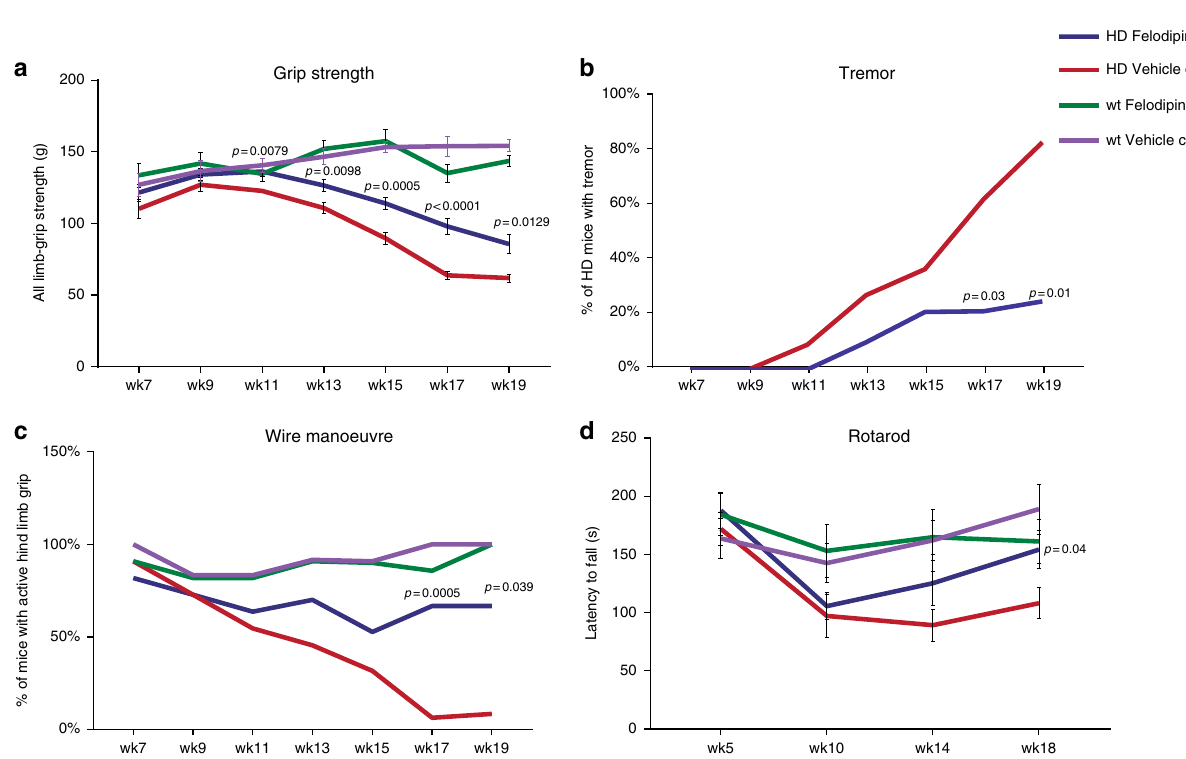
Fig. 3 Ef fi cacy study of felodipine in N171-82Q (B6HD) mice. B6HD male mice were given i.p. injections of 5 mg/kg felodipine or carrier substance (vehicle control) three times a week from 6 weeks of age. Wild-type mice littermates were also given felodipine or vehicle control injections with the same frequency. n = 22 mice for B6HD mice for both felodipine and vehicle control groups, while n = 11 for wild-type felodipine-treated littermates and n = 12 for wild-type vehicle-treated littermates. a Felodipine improved grip strength in B6HD mice. All B6HD mice showed some age dependent decline in grip strength compared to wild-type littermates regardless of treatment. However, felodipine signi fi cantly improved the decline in grip strength in B6HD mice relative to vehicle-treated B6HD mice at the time-points indicated. Data are shown as mean values + / − SEM; one-way ANOVA with post hoc Fisher ’ s LSD test; exact p values for B6HD-felodipine vs. B6HD-vehicle control are shown. Felodipine treatment had no effect on grip strength in wild-type mice. b The severity of tremors in B6HD mice was signi fi cantly improved by felodipine treatment at 17 and 19 weeks. Mann-Whitney two-tailed test was performed for ranked data; exact p values are shown. c Felodipine treatment improved performance at the wire manoeuvre task at 17 and 19 weeks in B6HD mice. Mice were scored on their ability to perform the wire manoeuvre task, data for the active grip with hind limbs are shown and analysed using one-way ANOVA for non-parametric data (Kruskal-Wallis with Dunn ’ s multiple comparison test); exact p values for felodipine vs. vehicle control in B6HD mice are shown. d Felodipine treatment improved rotarod performance in B6HD mice at 18 weeks. Data are presented as mean values + / − SEM; one-way ANOVA with post hoc Fisher ’ s LSD test; exact p values for felodipine vs. vehicle treated B6HD mice are shown. HD-vehicle control mice had a signi fi cantly reduced performance on the rotarod at week 10 and 14, compared to wild-type littermates (both felodipine-treated and vehicle-treated), as would be expected based on their known disease Felodipine pharmacokinetics . Felodipine is an FDA-approved predicted it would likely provide long-term upregulation of antihypertensive drug with a recommended dosing pro fi le of 2.5 autophagy. However, we do not know how the pharmacokinetics mg – 20 mg/day 19 . We selected felodipine as the best candidate in mice compare with those in man. In humans taking felodipine drug from a panel of L-type calcium channel blockers based on as an antihypertensive drug (10 mg daily dose), the peak plasma BBB-penetration and long half-life in man and therefore we concentration in males is 28 nmol/L and is 33 nmol/L in females